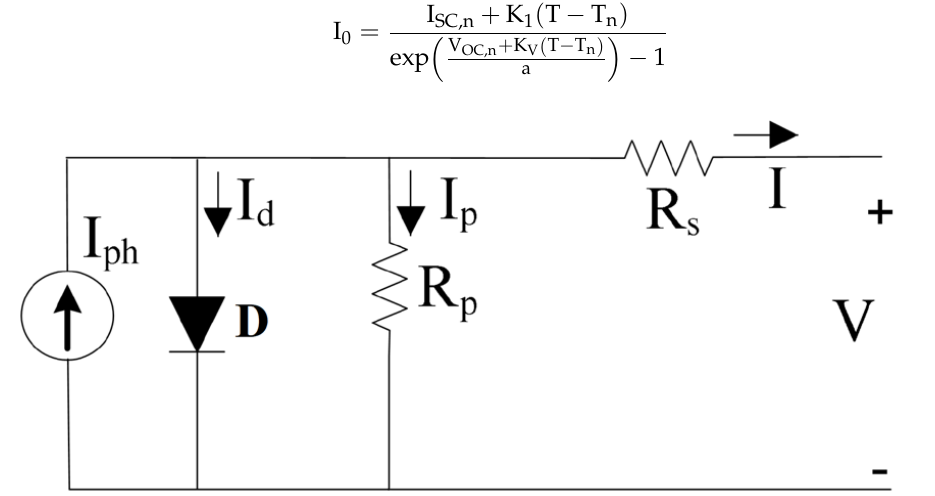
Figure 2. Electrical equivalent circuit model of PV cell.